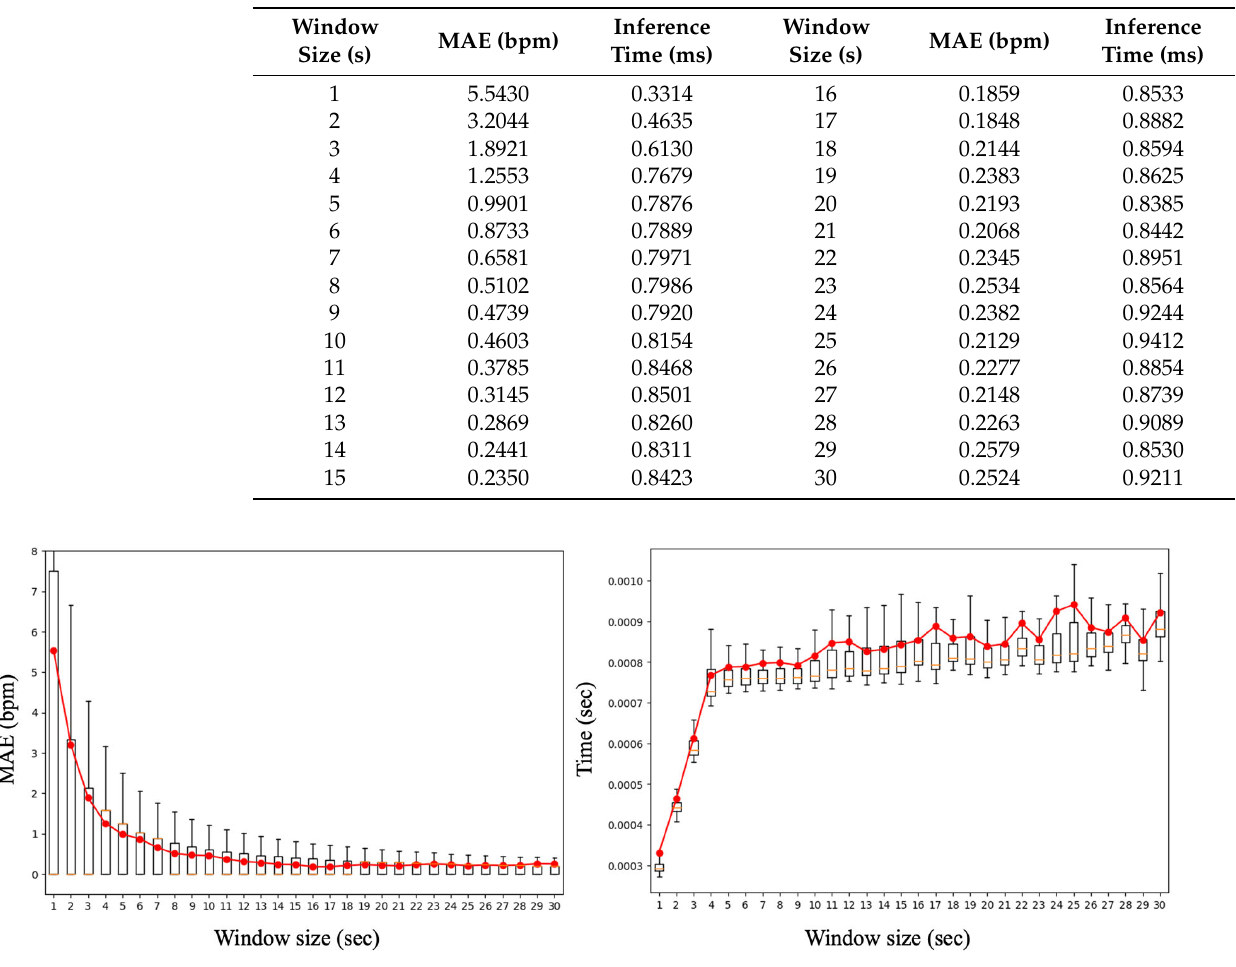
Table 3. The changes in the accuracy and inference time according to window size.